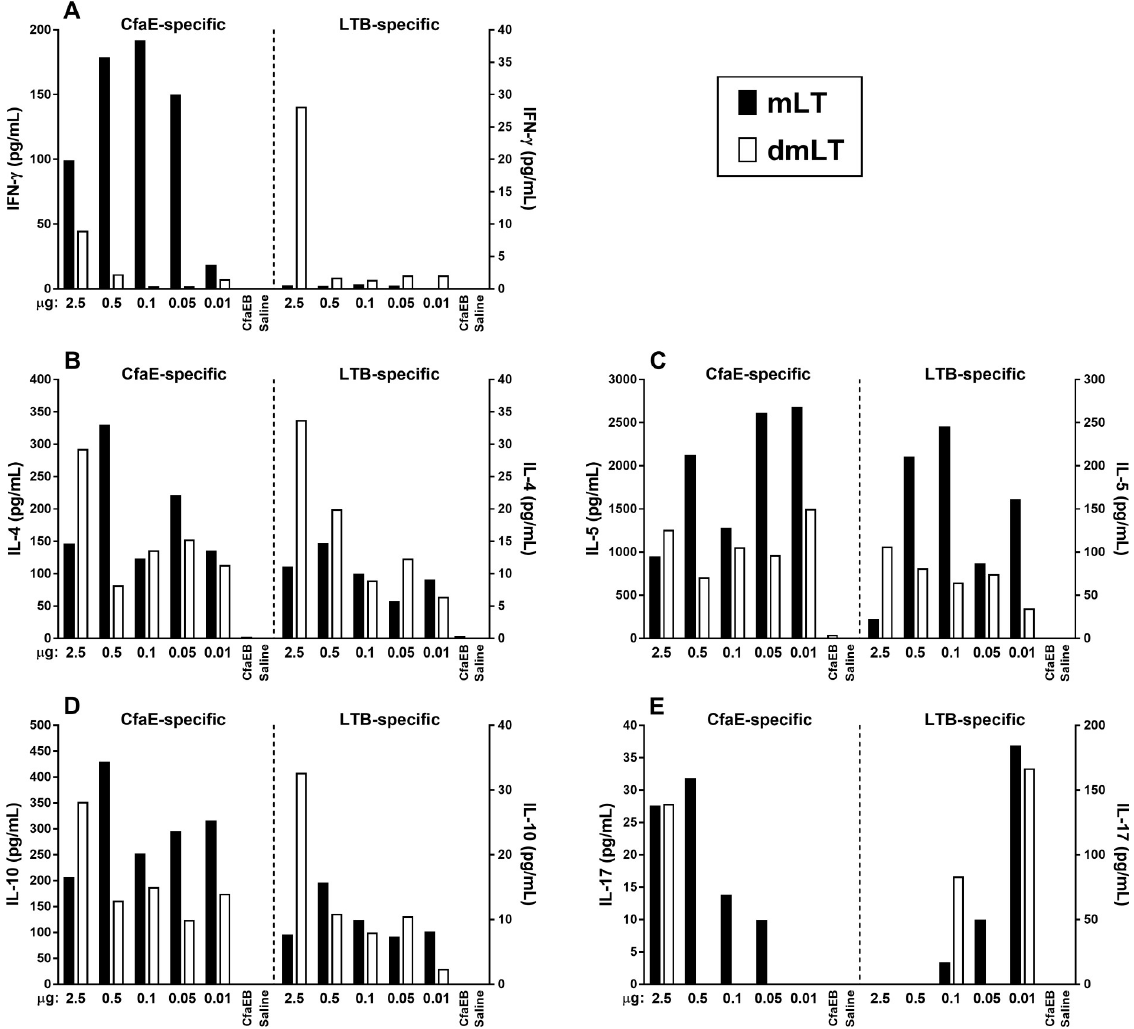
Fig 7. Evaluation of cytokine secretion. Two weeks after the third immunization, animals were euthanized and three spleens from each group were homogenized, pooled and cultured as described in material and methods section. Supernatants were assayed in duplicate by Luminex and the results are shown as net values after subtractions of the cytokine levels obtained with medium only. All samples responded with very high levels of all cytokines under ConA stimulation. Bars represent the average result of duplicate assays. (A) Interferon-gamma; (B) IL-4; (C) IL-5; (D) IL-10; (E) IL-17.